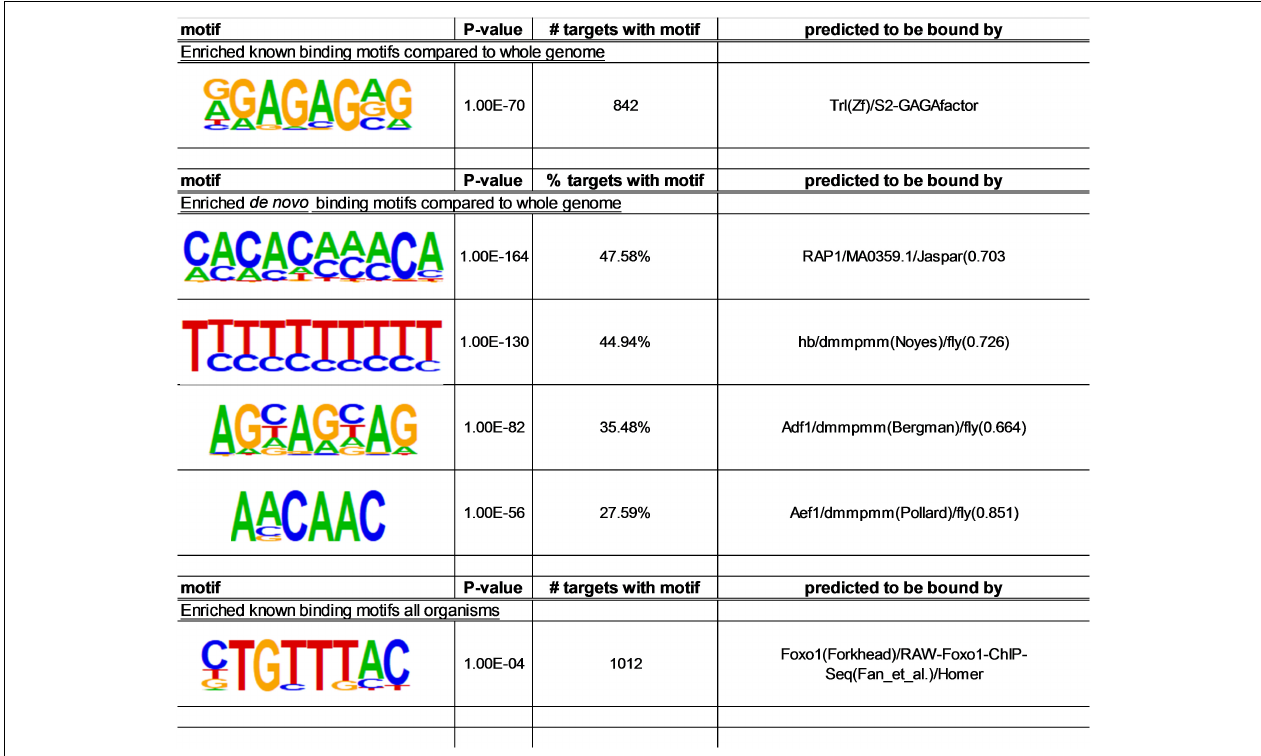
FIGURE 6 | Lists of motifs that are enriched among FOXO target sites in wild-type flies. Motifs within 200 bp surrounding the peak region were analyzed using Homer. Three methods were used: motif search against insect motif databases; de novo motif search; motif search against known mammalian motifs.